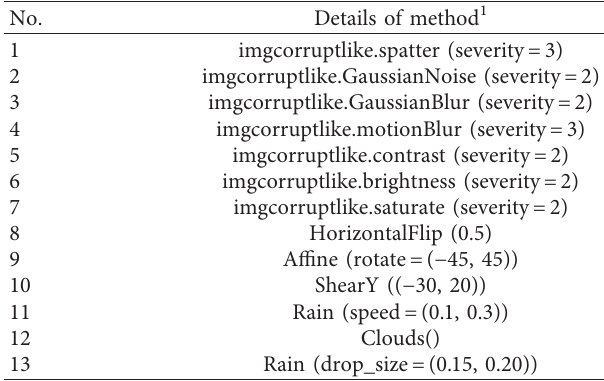
Figure 3: Sample of image in outdoor and indoor datasets. (a) Green. (b) White. (c) Yellow. Table 2: Details of code augmentation method. Table 3: Details of image augmentation